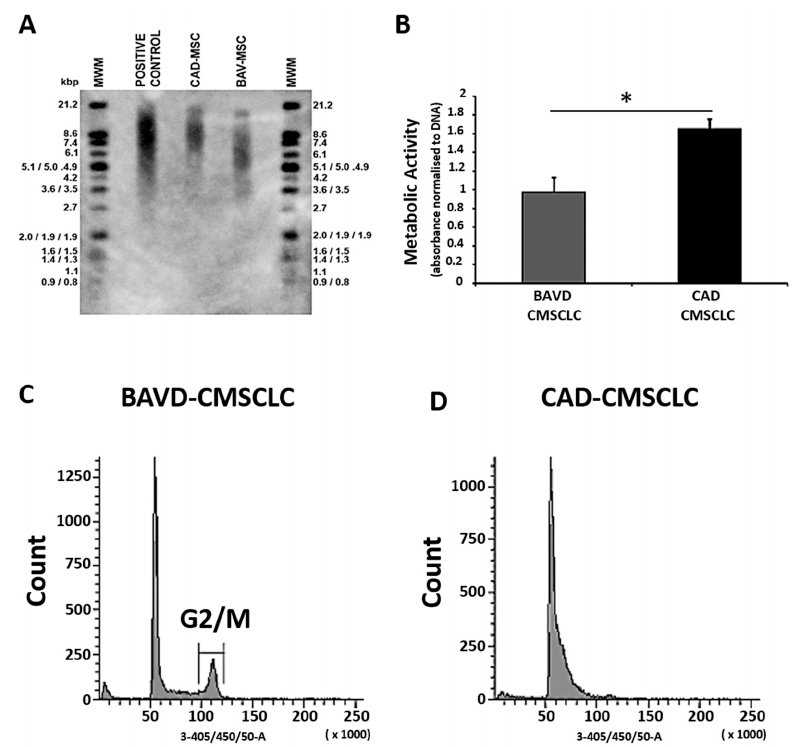
Figure 4. Evaluation of CMSCLC senescent phenotype ( A ) Measurement of CMSCLC telomere length. ( A ) TeloTAGGG Telomere Length Assay was used to measure telomere length of BAVD-CMSCLC and CAD-CMSCLC. Resolved telomere fragments from Hinf I/Rsa I-digested control gDNA, CAD-CMSCLC gDNA and BAV-CMSCLC gDNA were hybridized with DIG-labelled telo-